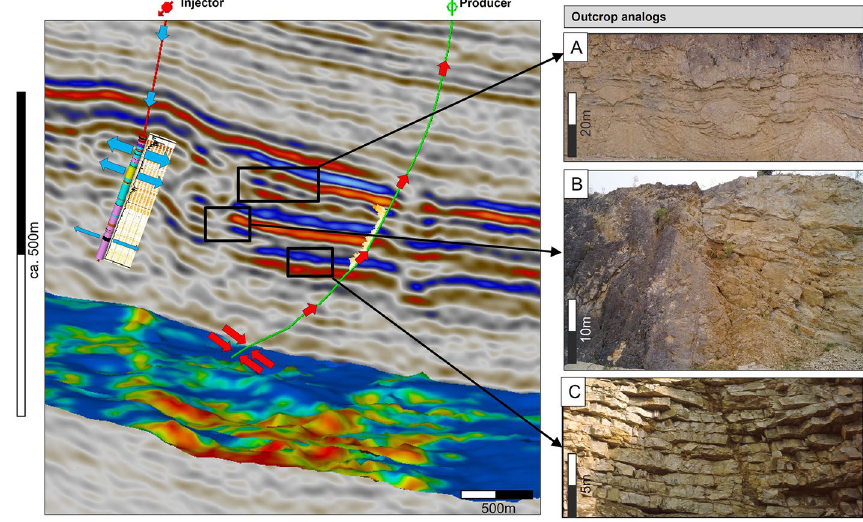
Fig. 14 Conceptual comparison of the three dominating seismic facies types interpreted in this study with outcrop analog observations of the Upper Jurassic outcrops from the Swabian Alb. A bioherm/reef debris ( subparallel low amplitude seismic facies) comprised of large olistoliths can be up to 40–50 m thick and = are typically present during the (late) HST of sequence 3. B Onlaps of the well-bedded basin facies ( high-amplitude seismic facies) onto the bioherm/reef buildups (chaotic seismic facies) show a very sharp contact and can be frequently observed in the field. C Well-bedded limestone with frequent clay–marly alternations interpreted as basin facies observed in the outcrop and interpreted as parallel